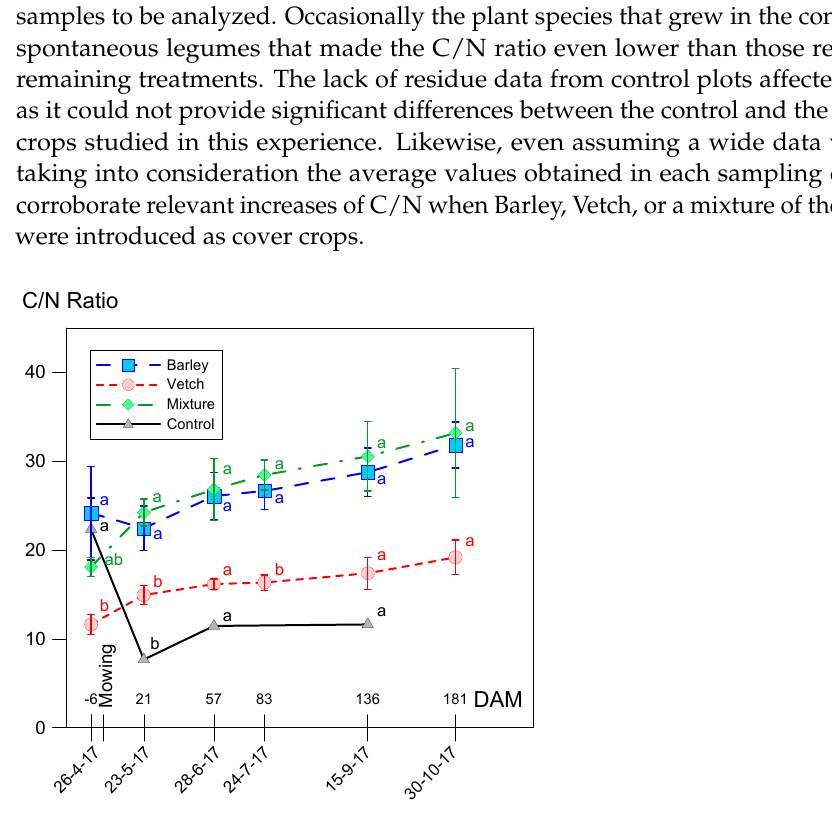
Figure 8. The C/N ratio dynamics throughout the decomposition process during the first season. Vertical bars represent standard error. Different letters in each measuring date are statically different based on the LSD test ( p ≤ 0.05). No biomass samples from control plots in July and the last sampling date. DAM, days after mowing. X units follows the format DD-MM-YY.